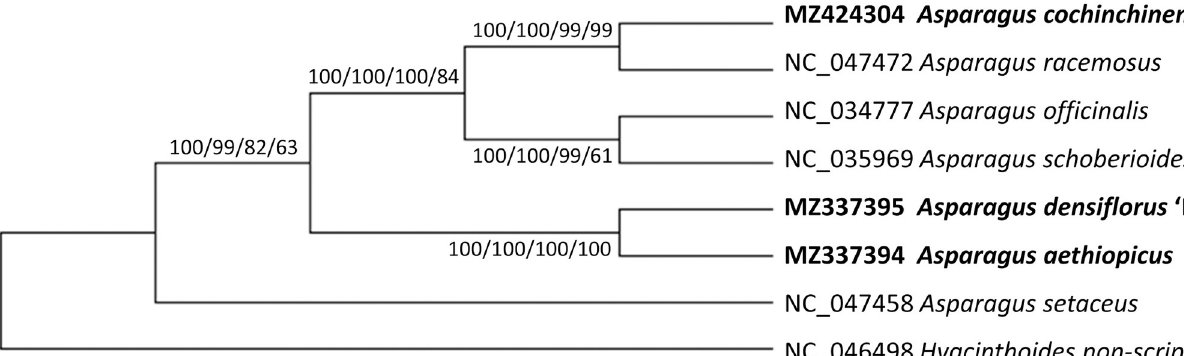
Fig 10. Maximum likelihood (ML) trees based on Asparagus cpDNA genomes. Numbers next to the nodes: bootstrap values based on complete cpDNA genomes/LSC/SSC/CDS sequences. The topologies are identical. Bold taxa: the three newly assembled cpDNA genomes.